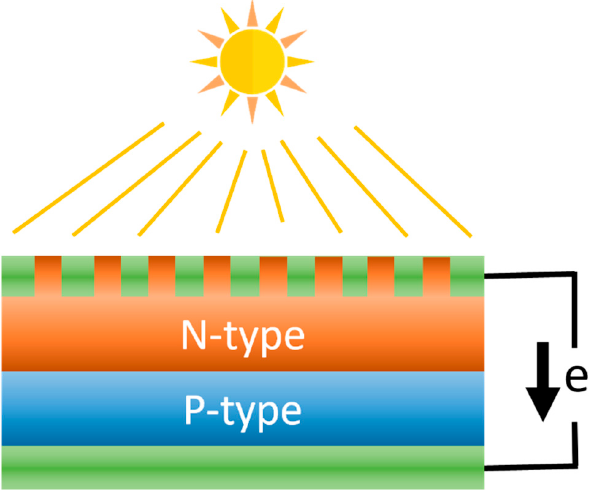
Figure 12. Solar energy harvesting [9].